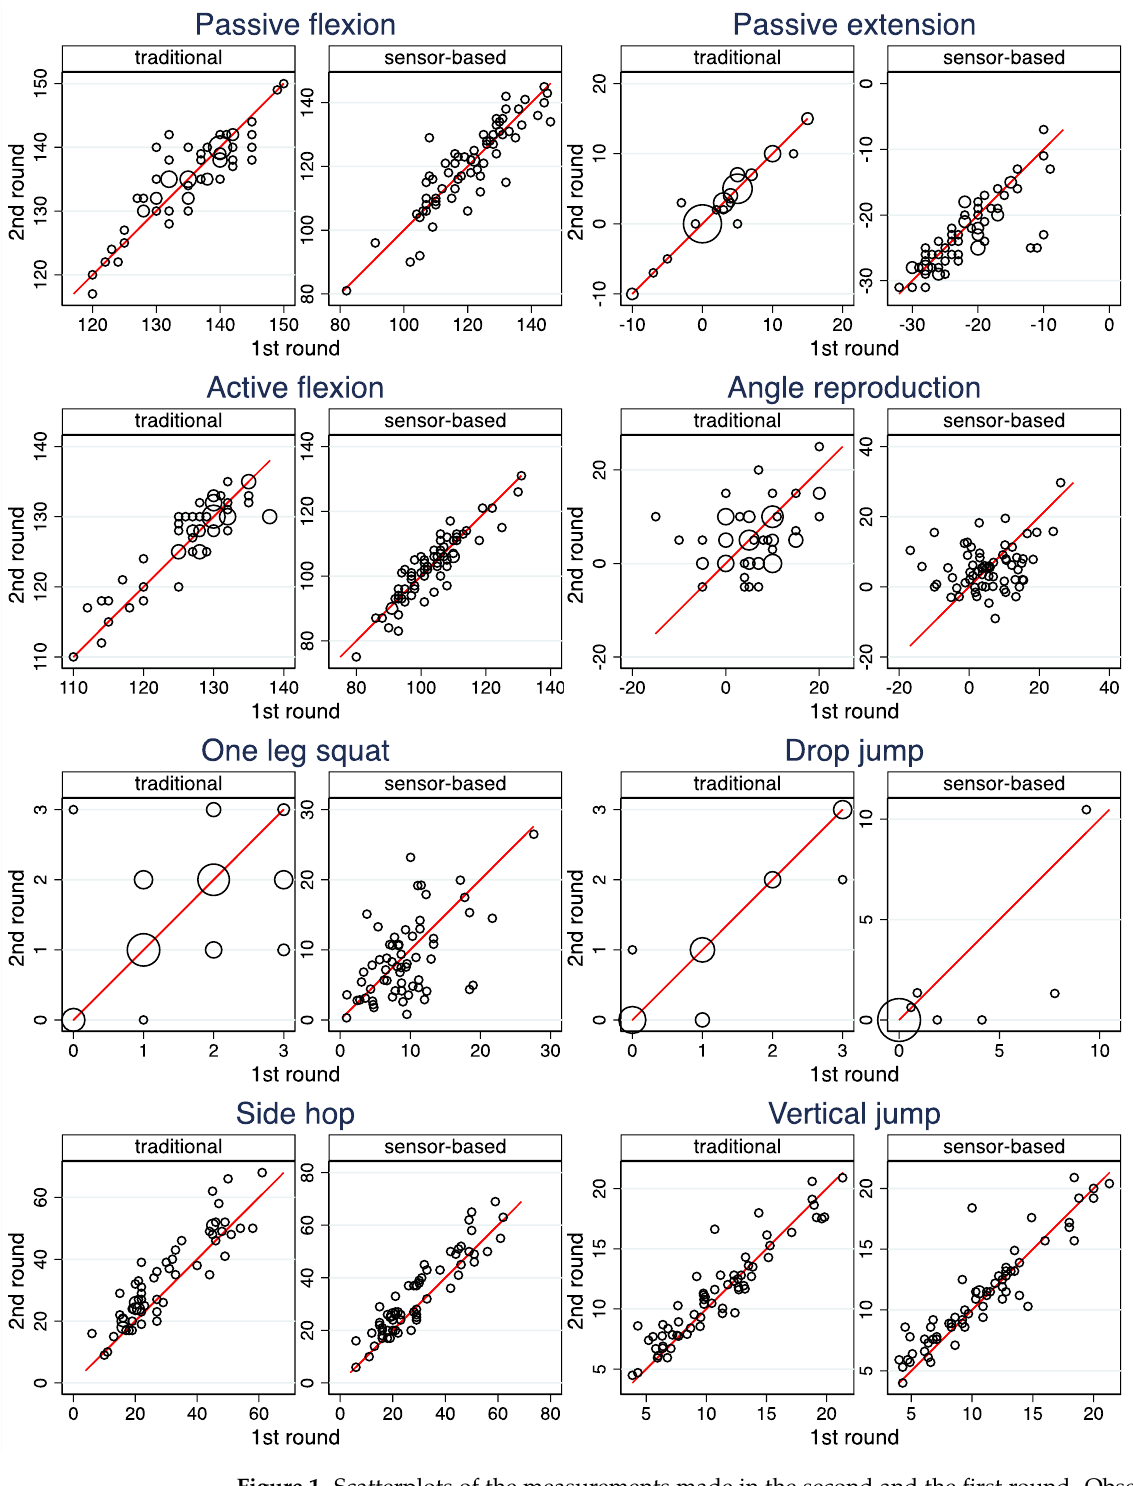
Figure 1. Scatterplots of the measurements made in the second and the first round. Observations from both legs are included in the same scatter plot. The area of the circles is proportional to the number of observations. The red line indicates equality of the two measurements.